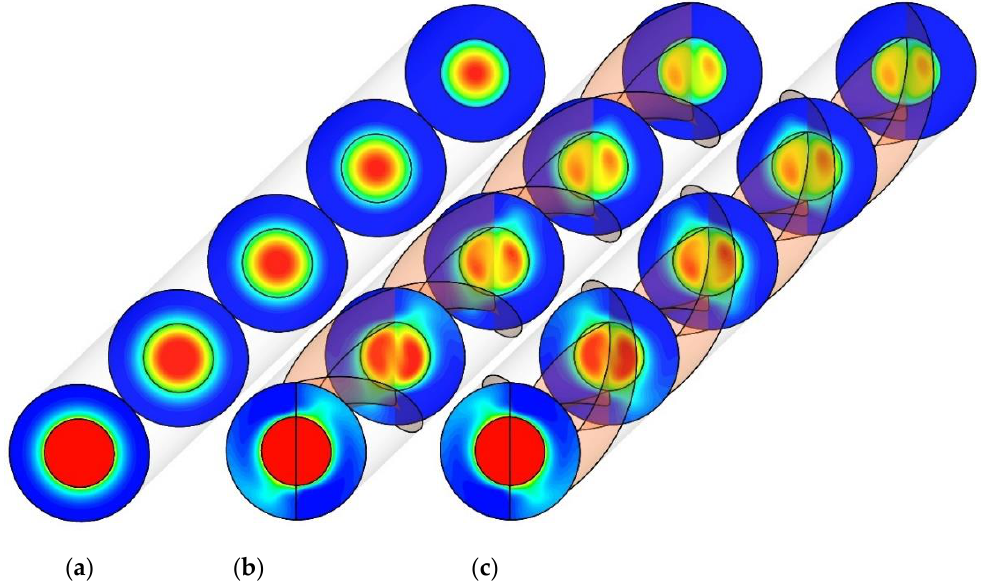
Figure 10. Cross-sectional temperature contours at Reynolds number of 250 for: ( a ) PHE; ( b ) Co-STT; and ( c ) Counter-STT.